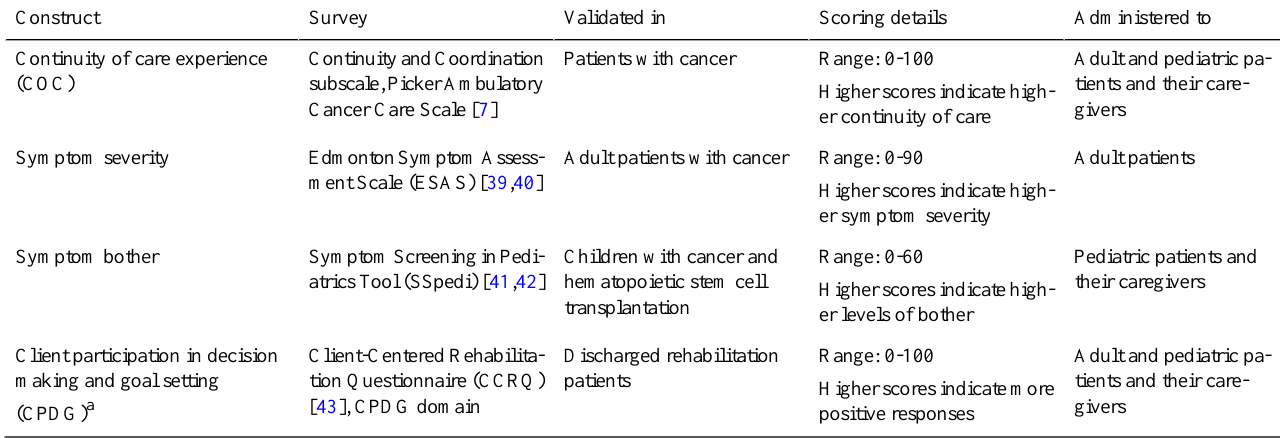
Table 1. Patient and caregiver outcome